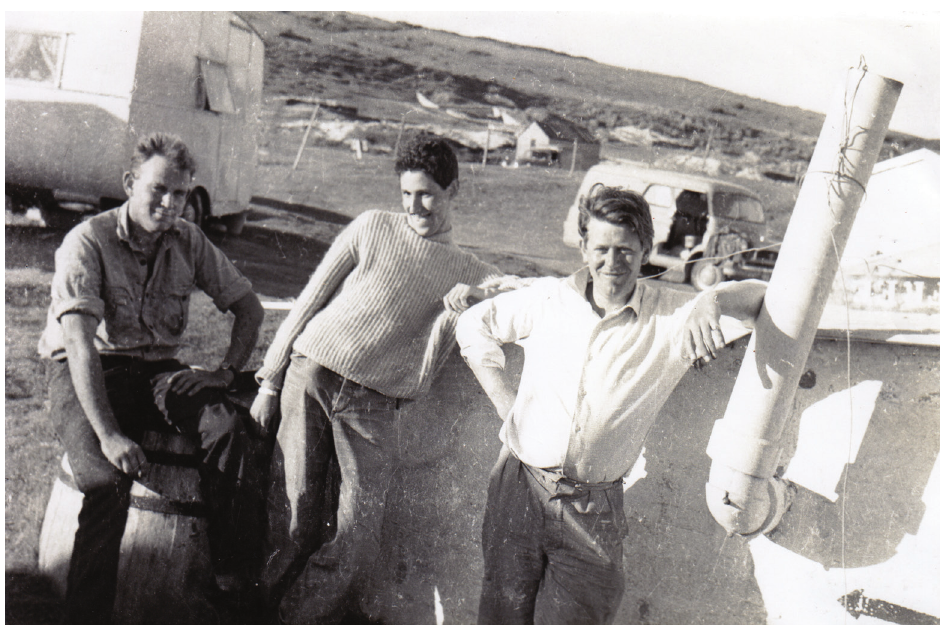
Fig. 1: Charles Thomas (right), with his co-directors of the Gwithian excavations in north Corn- wall, Vincent Megaw (centre) and the late Bernard Wailes (left), in the summer of